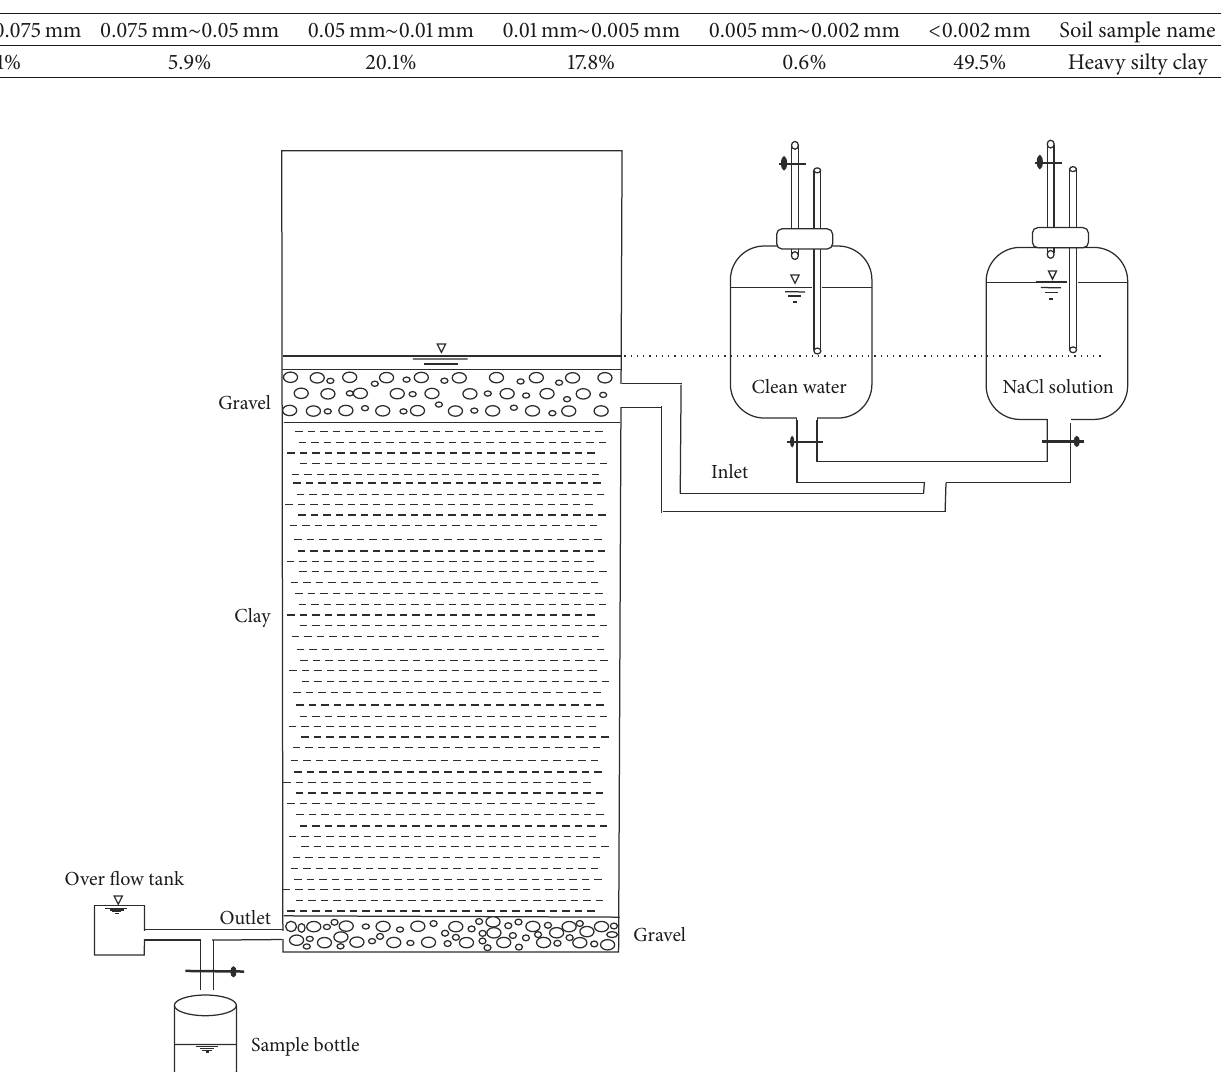
Table 1: Summary of soils sample diameters and particle size distribution (%).